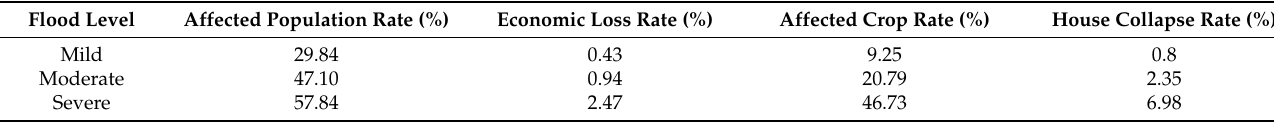
Table 5. Vulnerability to floods of different levels in Cangnan County.